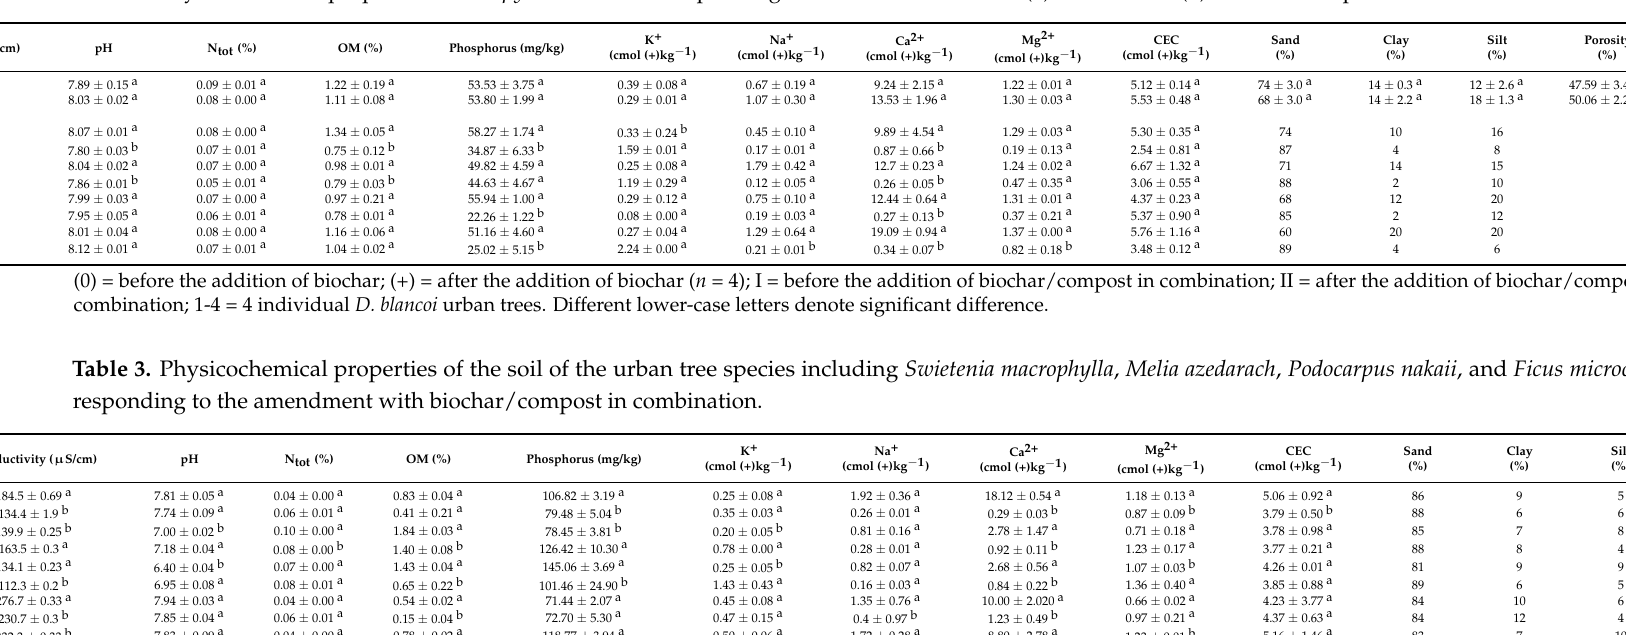
Table 2. Physicochemical properties of Diospyros blancoi soil responding to the amendment with (a) biochar and (b) biochar/compost in combination.